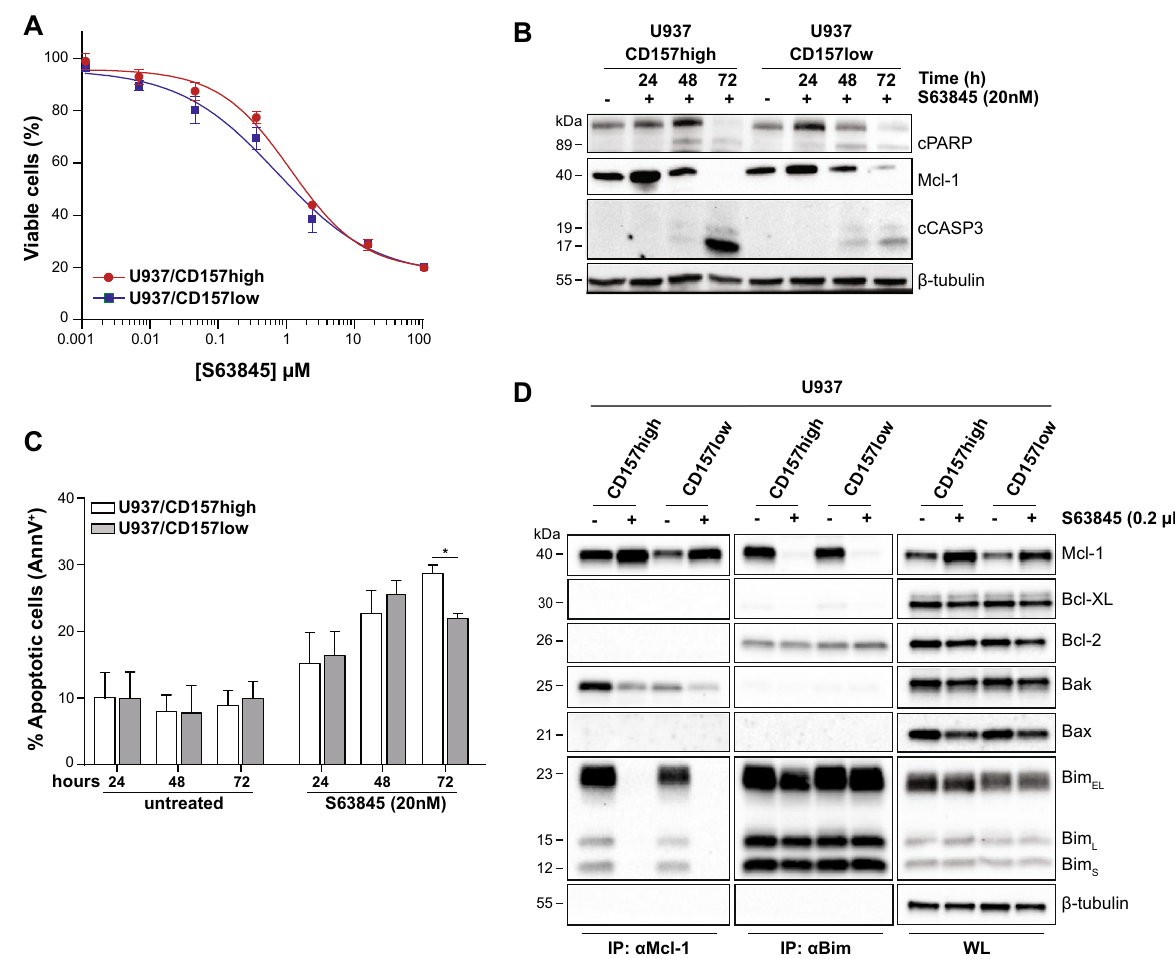
Figure 4. CD157 promotes survival of leukemic blasts through Mcl-1 upregulation. ( A ) CD157-high (red line) or CD157-low (blue line) U937 cells were treated for 24 h with increasing concentrations of S63845, then cell viability was determined by Presto Blue assays. Data represents the percentage of live cells compared to control cells treated with vehicle and are the mean ± SEM of three experiments performed in six replicates. ( B ) Western blot analysis of PARP-1, Mcl-1 and cleaved Caspase-3 in CD157-high or CD157-low U937 cells treated with S63845 for 24, 48 or 72 h. β-Tubulin was used as loading control. Uncropped blot images are provided in Supplementary Fig. S11. ( C ) CD157-high or CD157-low U937 cells were treated for up to 72 h with S63845. Cell apoptosis was measured by flow cytometry analysis after AnnexinV/PI staining. Results are the mean ± SEM of three experiments. * p < 0.05, two-way ANOVA with Sidak’s multiple comparison test. ( D ) U937/CD157-high or U937/CD157-low cells were treated with S63845 for 24 h, then lysed and subjected to immunoprecipitation with anti-Mcl-1 or anti-Bim antibody, respectively. The interactions with the indicated proteins were analyzed by immunoblotting. β-Tubulin was used as loading control. One representative Western blot is shown (n = 3). The whole cell lysates (WL) show the protein expression levels. Uncropped blot images are provided in Supplementary Fig.